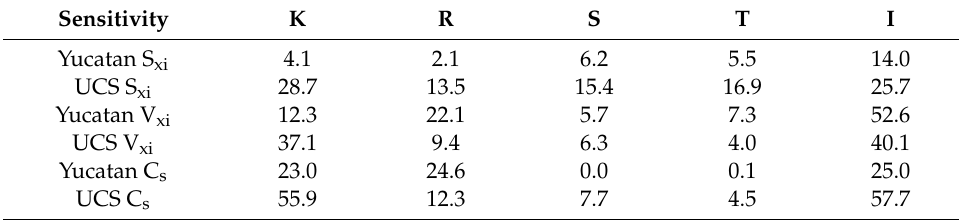
Figure 5. Percentage comparison of vulnerability classes displayed in Yucatan from four vulnerability methods.